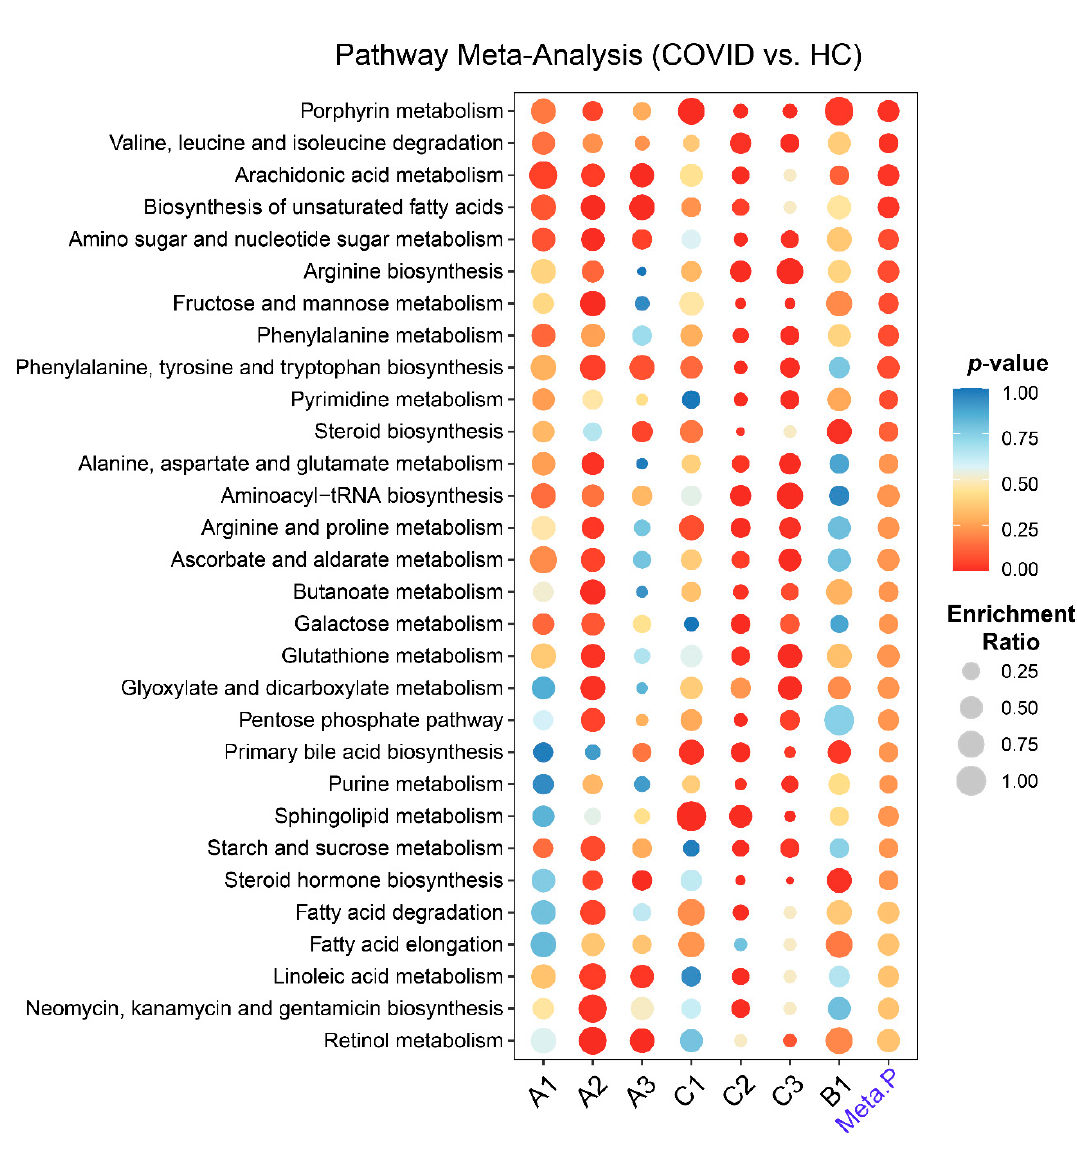
Figure 3. Pathway analysis and meta-analysis between COVID-19 and healthy controls (HC) across the seven datasets. Each row represents a pathway and each column represents a dataset. The rightmost column shows the result from the meta-analysis.